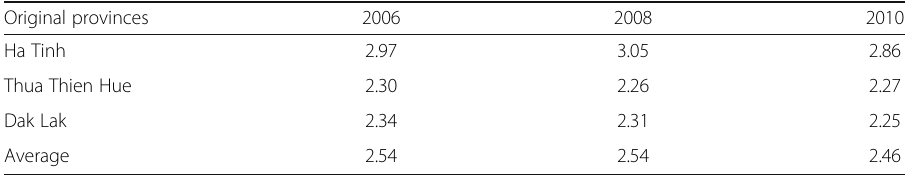
Table 1 Disparity of income of main destinations and original provinces Original